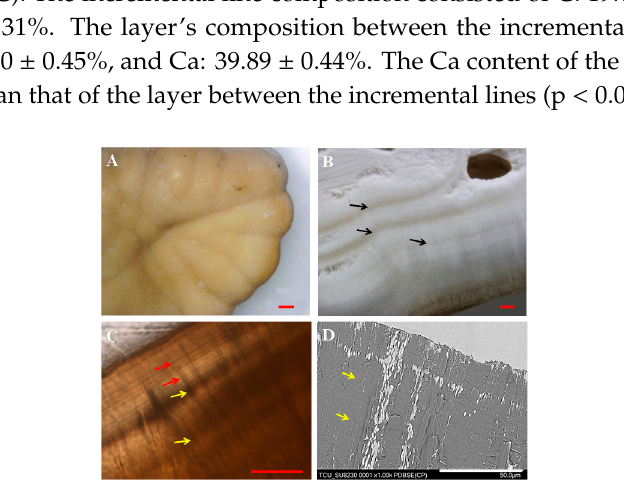
Figure 4. Micrograph of Cetonurus noboriensis (Aoki and Baba). The narrower incremental lines were regularly observed ( C , red arrows). The narrower incremental lines were spaced 1.5–3.4 µ m ( D , yellow arrows). The long-period incremental lines (average 63 µ m: yellow arrows and average 118 µ m: black arrows) were observed ( B , C ). Digital microscopy images ( A : otolith surface, B: cross-sectional image). Ground specimen of polarizing micrograph ( C ). SEM micrograph ( D ). Scale bar: 500 µ m ( A ), 100 µ m ( B ), 50 µ m ( C , D ).